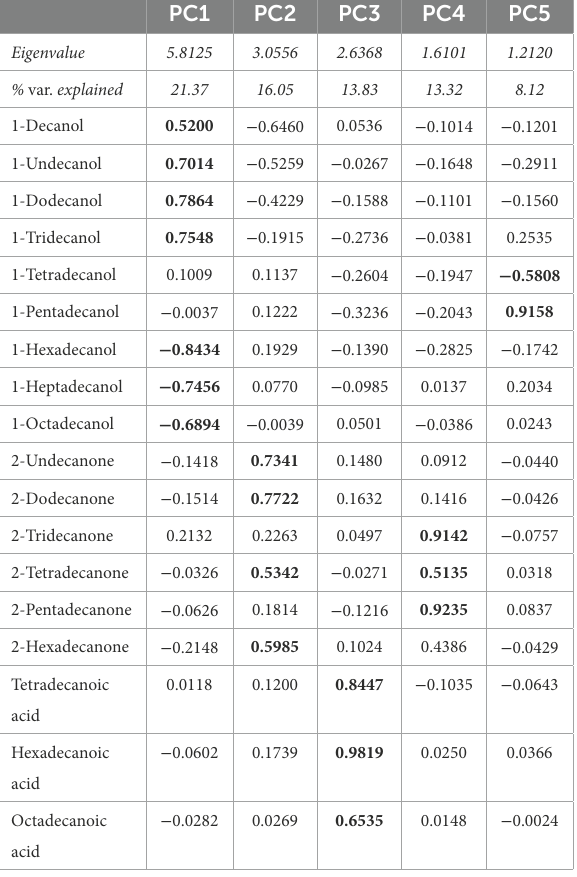
Bold text indicates volatile compounds most strongly associated with each